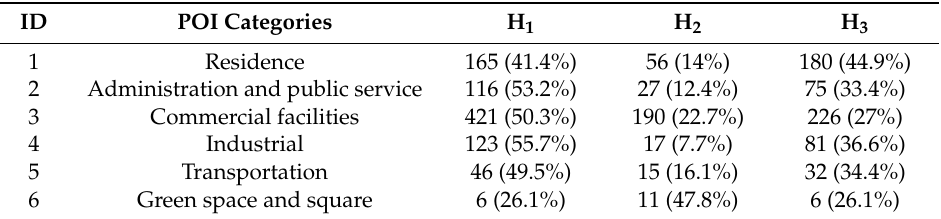
Table 3. POI point density for H 1 , H 2 and H 3 (points/km 2 ).